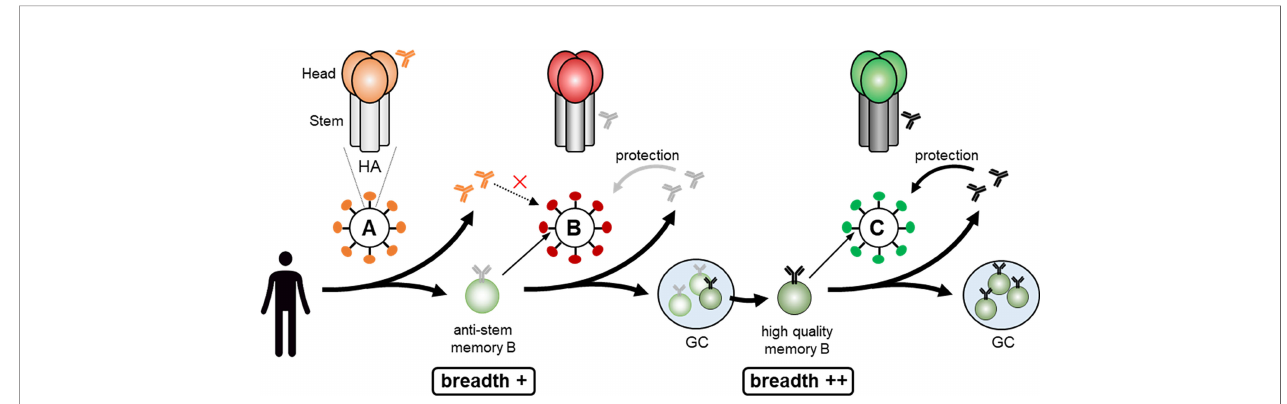
FIGURE 3 | Making high quality anti-stem memory B cell. Infection with the virus (A) results in generation of anti-stem memory B cells and low levels of anti-stem Abs. In this case, as there are no stem epitope masking Abs, anti-stem memory B cells are activated upon virus (B) infection, quickly produce anti-stem Abs, along with acquiring further breadth by entering GCs and subsequently generating more mature high quality memory B cells. Once the further distant virus (C) infects, high quality anti-stem memory B cells would play a signi fi cant role in protection from the virus (C)